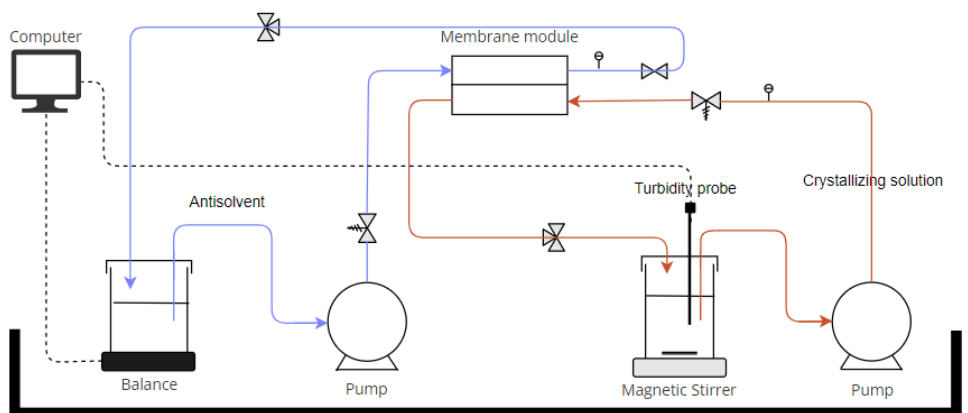
Figure 1. Schematic of the setup developed to evaluate the membrane performance of antisolvent crystallization under different conditions (variation of solutions velocity, antisolvent composition, temperature and gravity resistance).